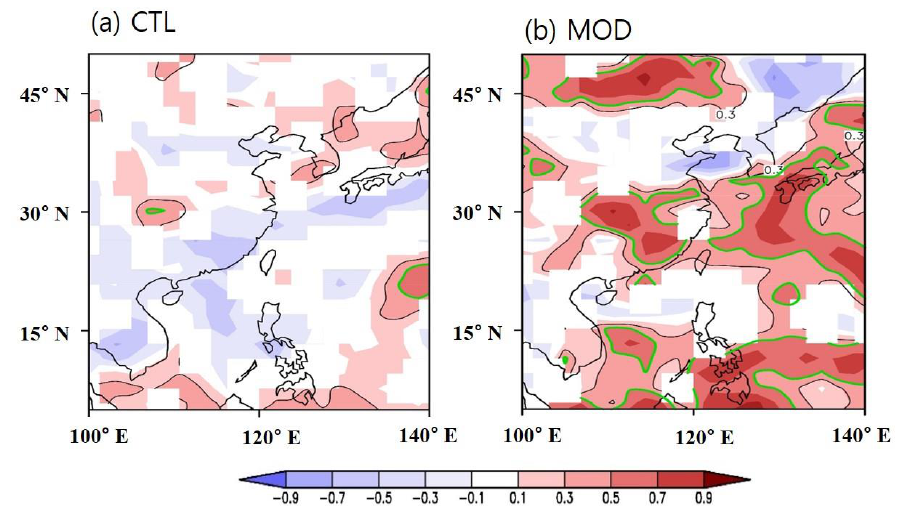
Figure 1. Temporal correlation coefficient of JJA mean precipitation from ( a ) the model without the modified parameterization (CTL)and ( b ) with the modified parameterization (MOD) over EA during 1980–2009. The green and black contours represent a coefficient of 0.5 and 0.3, respectively. Only significant areas are shaded (95%).